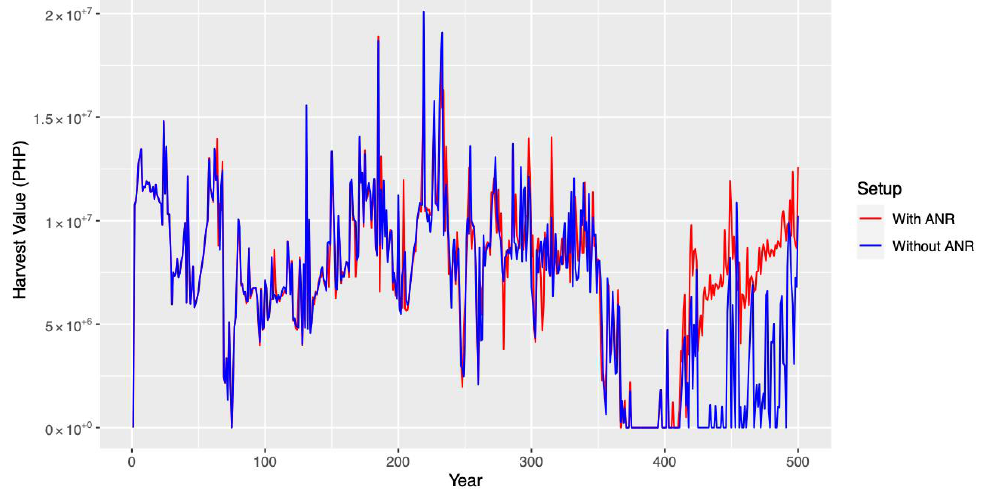
Figure 11. Comparison between the effect of implementing and not implementing ANR with respect to the total harvest value.